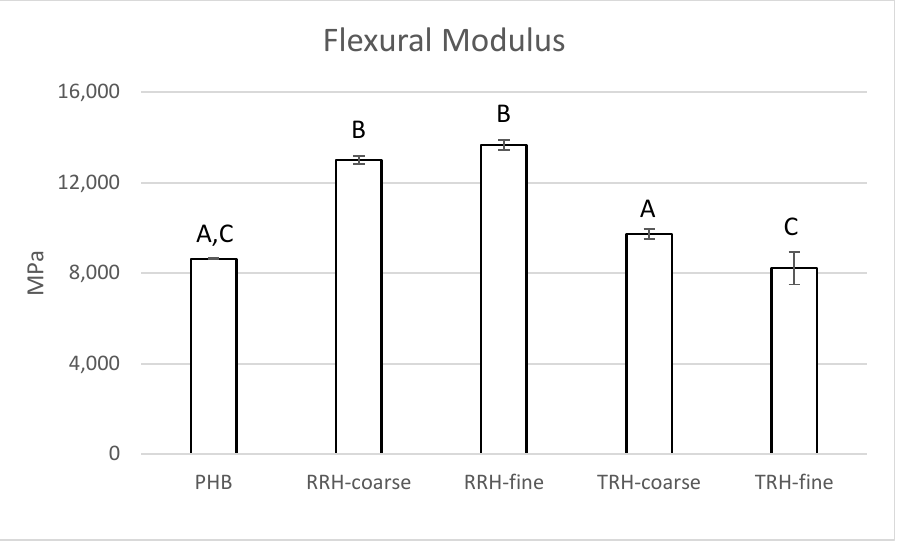
Figure 8. Flexural modulus measured for PHB, PHB with 10% coarse RRH, PHB with 10% fine RRH, PHB with 10% coarse TRH, and PHB with 10% fine TRH composite samples. Means with the same letter in each category are not significantly different by Tukey’s test ( α = 0.05).